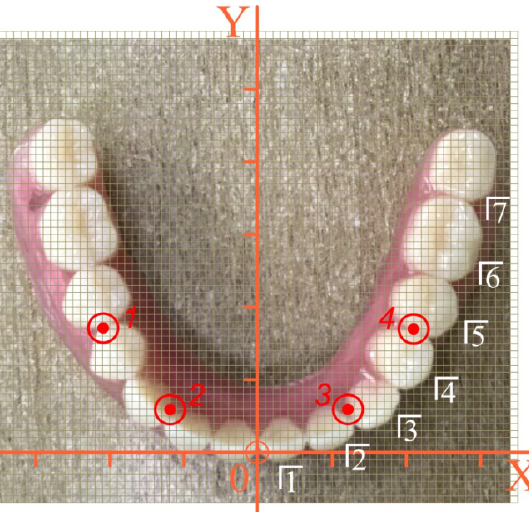
Figure 7. Numbering scheme and determination of the coordinates of the teeth and implants of a removable overdenture (the first variant of implant placement): red—implant number, white—tooth number.